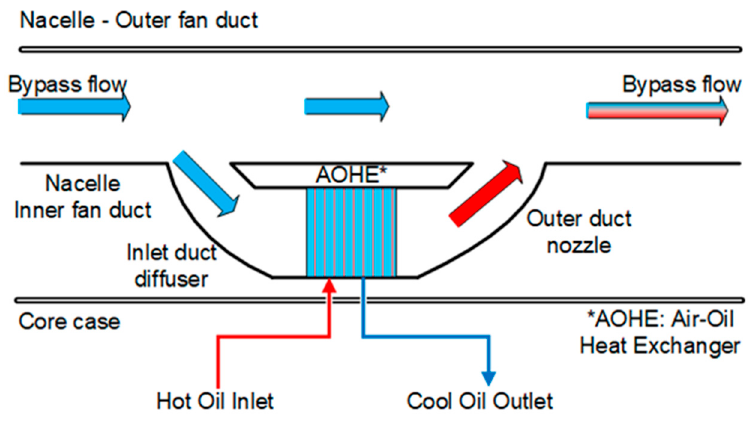
Figure 2. Bypass heat exchange system [32].